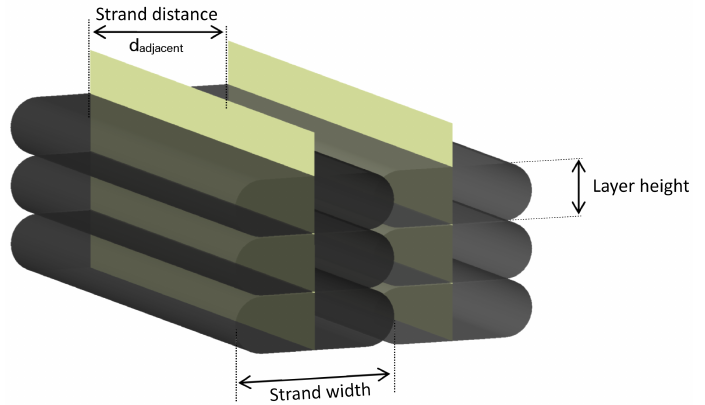
Figure 2. Schematic representation of a multi-walled sample at a strand distance with a negative air gap to reduce the macro-porosity between strands.